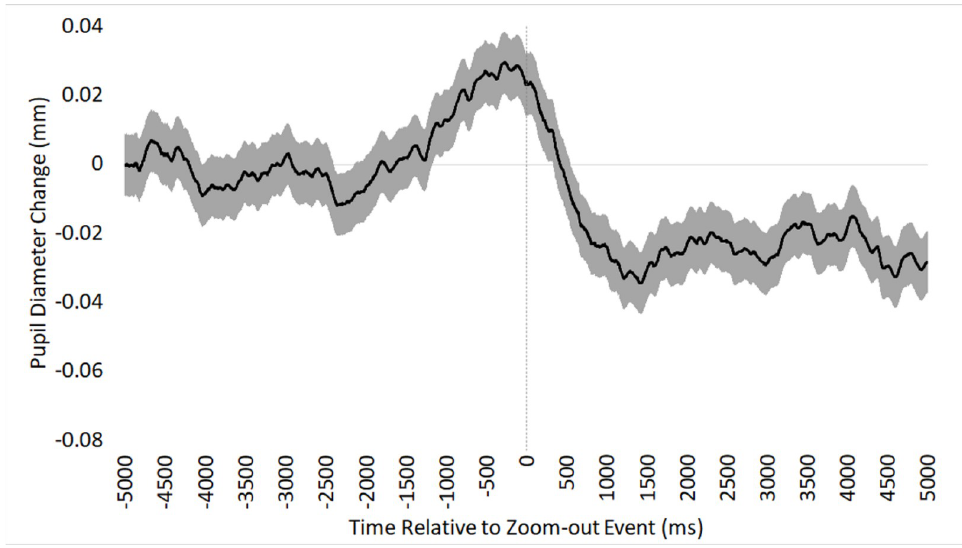
Fig 5. Hypothesis 4 phasic pupil diameter. Mean phasic pupil diameter response to zoom-out events over time (in ms), time-locked to the onset of a zoom-out event. Shaded region indicates standard error of the